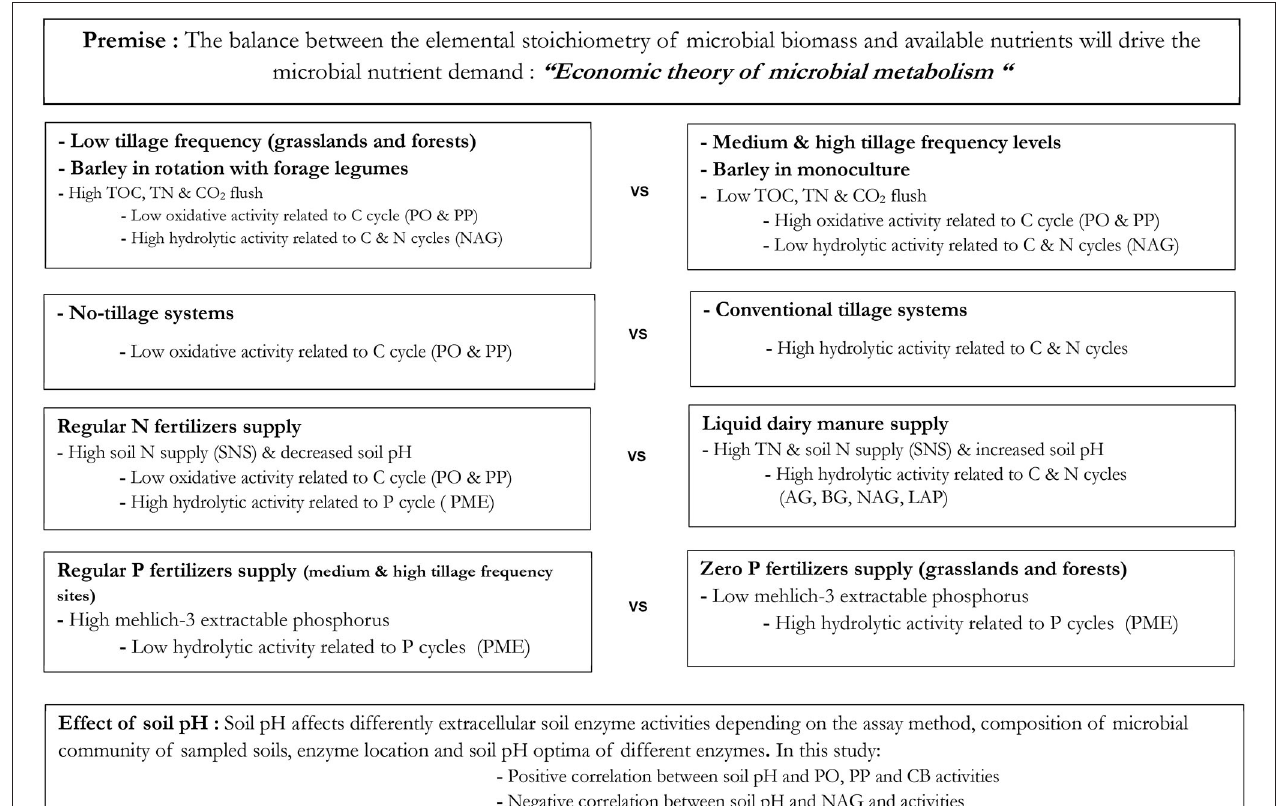
FIGURE 1 | Conceptual diagram summarizing the C, N, and P contents and extracellular enzyme responses to tested land-use. TOC, total organic carbon; TN, total nitrogen; CO 2 flush, carbon dioxide released after rewetting air-dried soil and incubating for 24h; SNS, soil nitrogen supply (extracted NO3-N plus NO3-N extracted following a 2-week aerobic incubation); M3-P, Mehlich-3 extractable phosphorus; AG, α -glucosidase; BG, β -glucosidase; NAG, β -1,4-N-acetylglucosaminidase; LAP, leucine aminopeptidase; PME, phosphomonoesterases; PO, phenol oxidase; PP, peroxidase.